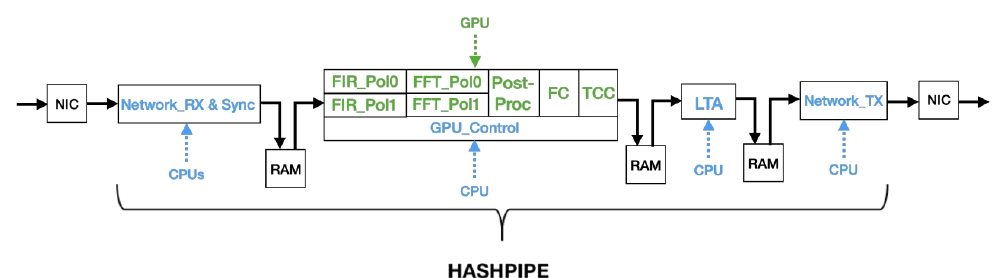
Figure 7. Diagram of the proposed full compact FX-engine